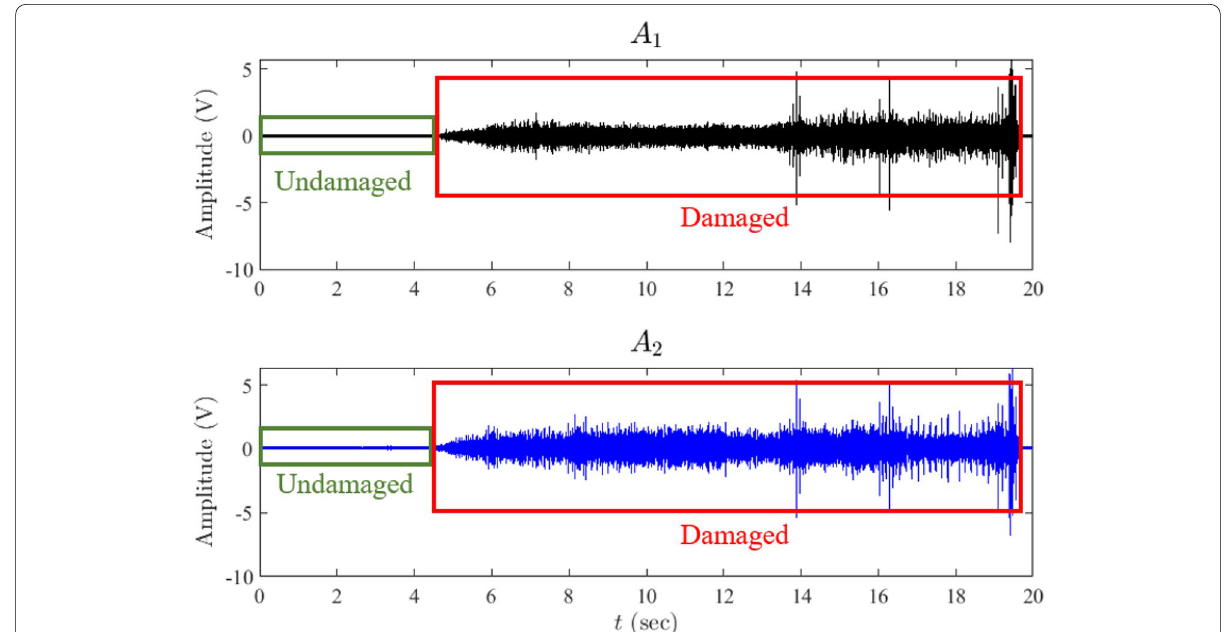
Fig. 9 Time-history of the measured AE data collected from sensors A 1 and A 2 of damage at D